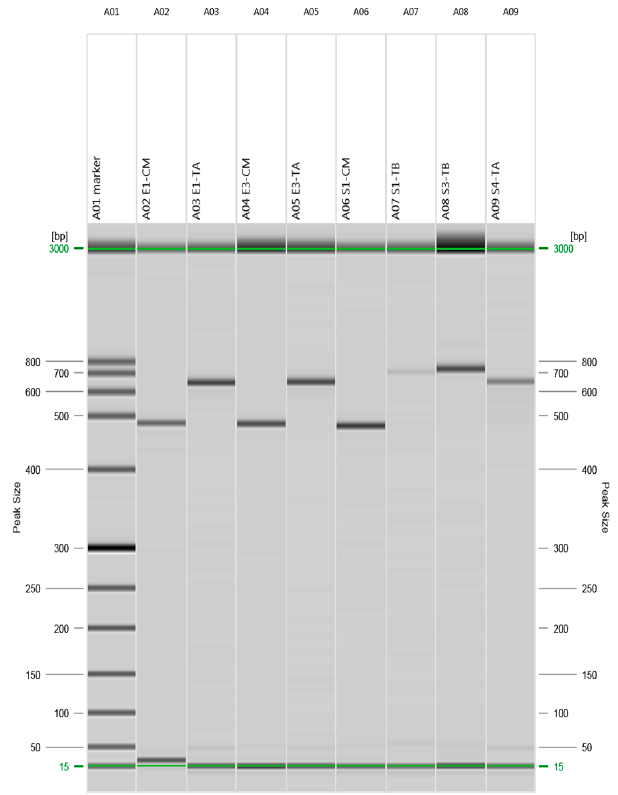
Figure 1. E1 = E. coli and S1 = Salmonella typhimurium were isolated from clinical samples, S3 = Salmonella typhimurium was isolated from poultry meat, and E3 = E. coli and S4 = Salmonella enteritidis were isolated from beef meat samples. CM represents beta-lactam-resistant gene and TA and TB represent tetracycline-resistant